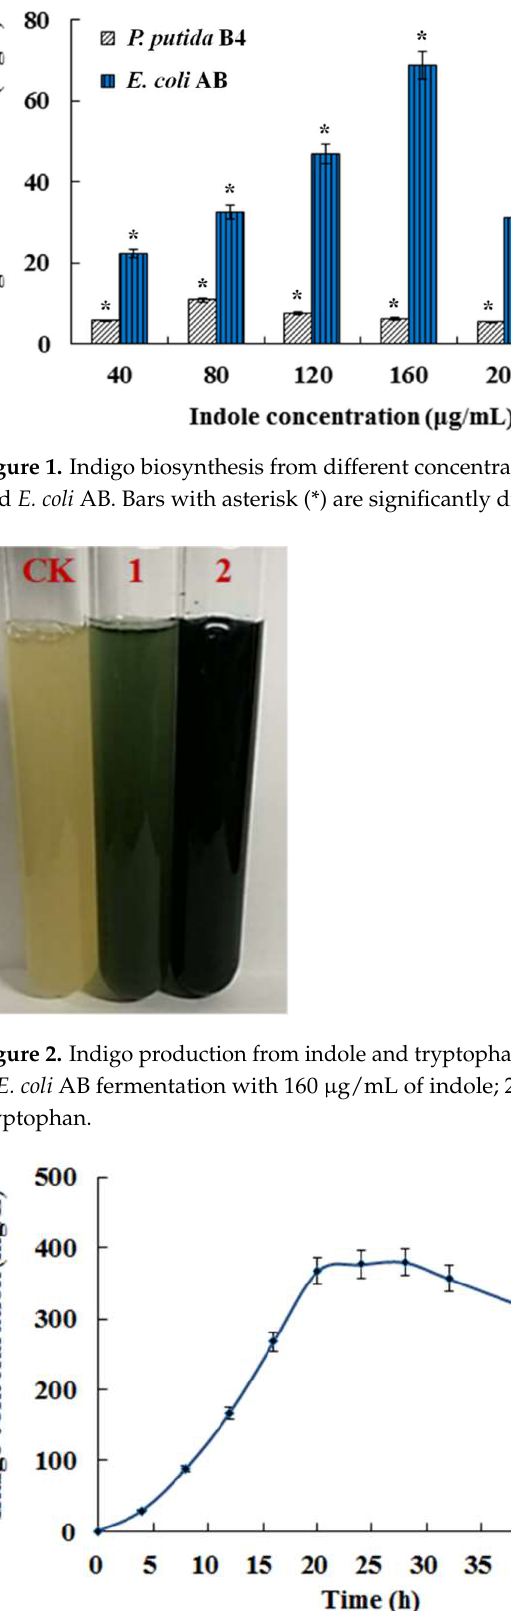
Figure 3. Indigo production from 1.0 mg/mL of tryptophan in E. coli AB fermentation.